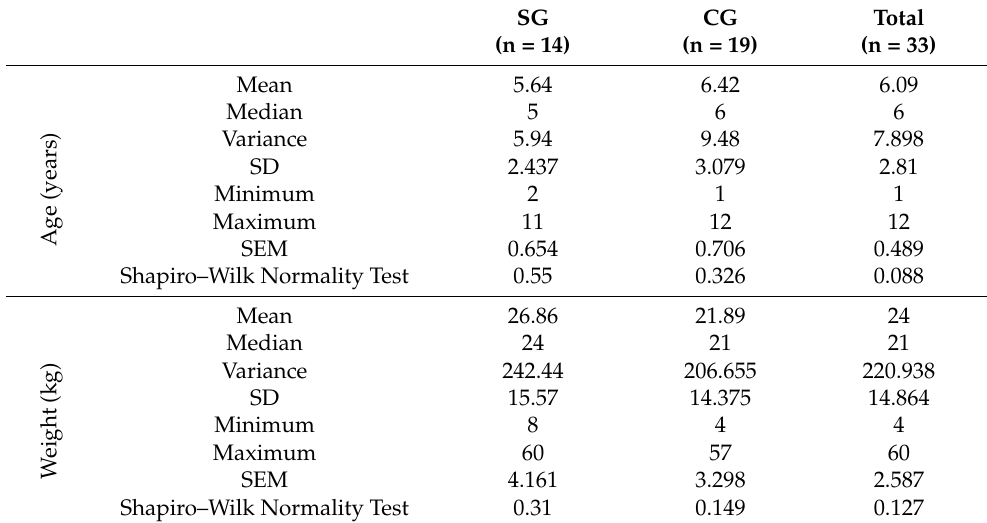
Table 4. Descriptive analysis of age and weight in both the study and control